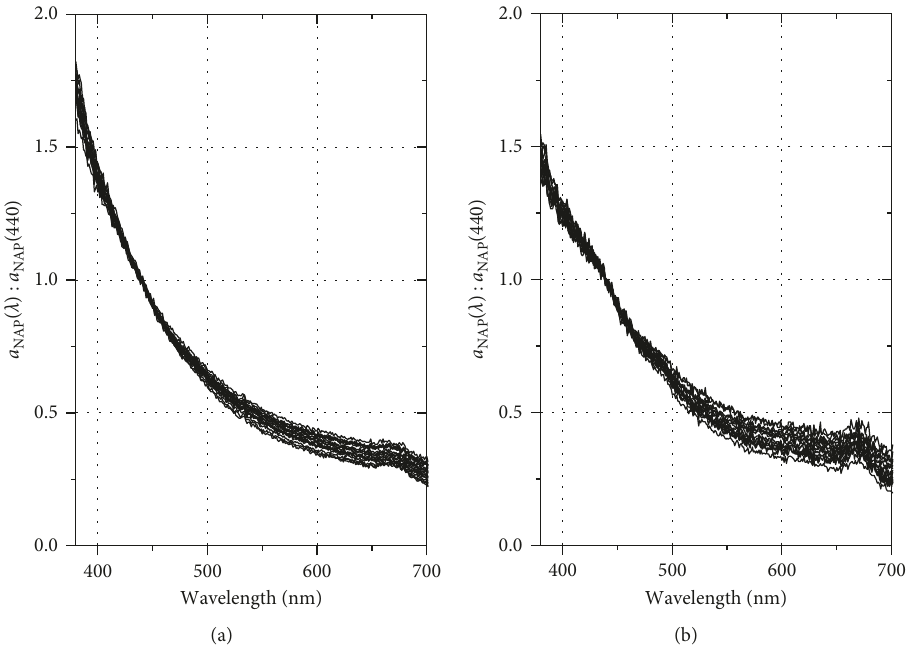
Figure 4: Nonalgal particulates of absorption spectra normalized to a